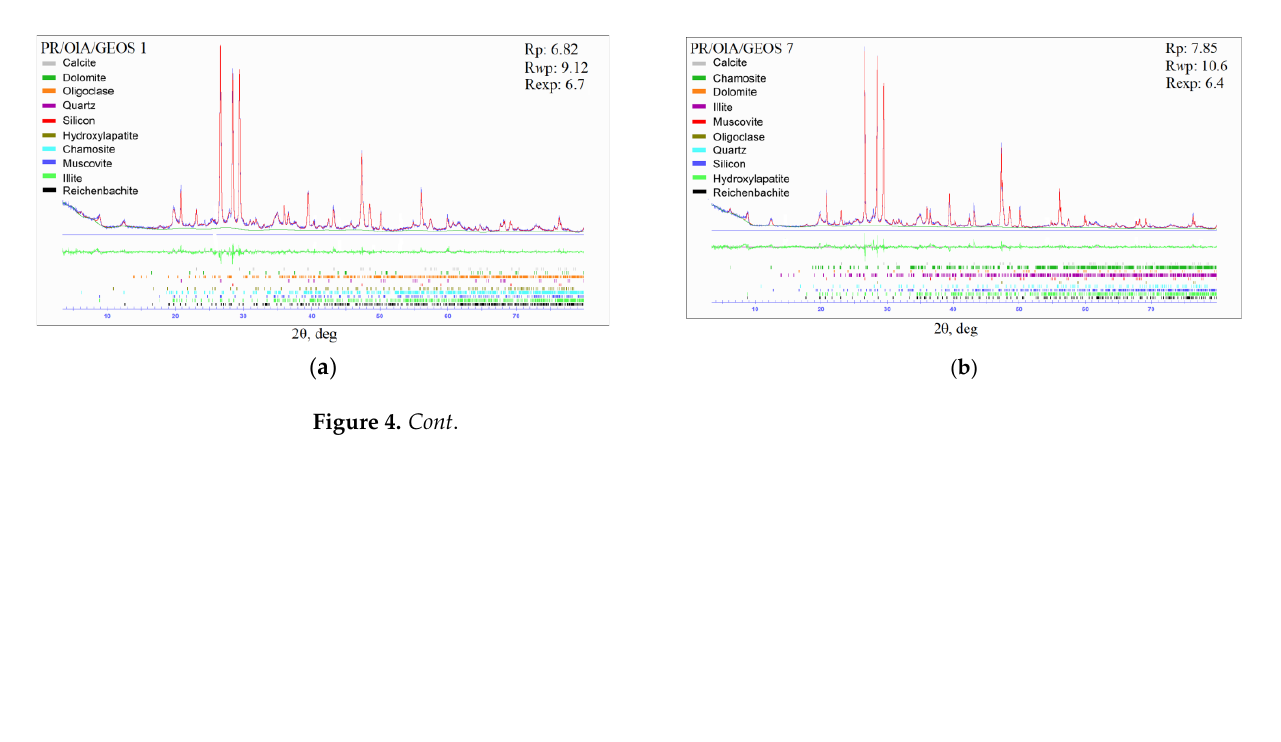
Figure 4 XRPD patterns refined by means of the Rietveld method for PR/OlA/GEOS samples after 1 ( a ), 7 ( b ), 14 ( c ), and 28 ( d ) days of curing with the addition of the external standard (crystalline silicon — Si). See Figure 3 for details.